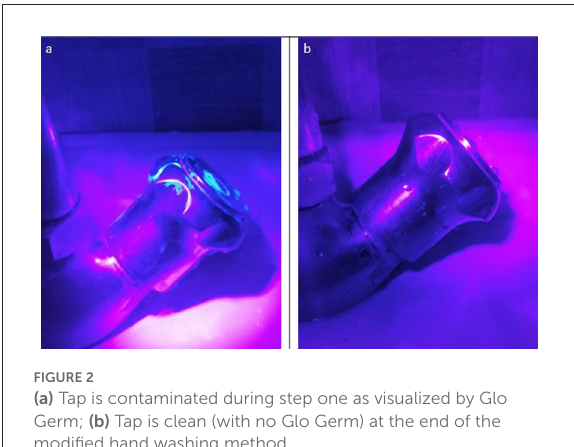
FIGURE2 (a) Tap is contaminated during step one as visualized by Glo Germ; (b) Tap is clean (with no Glo Germ) at the end of the modified hand washing